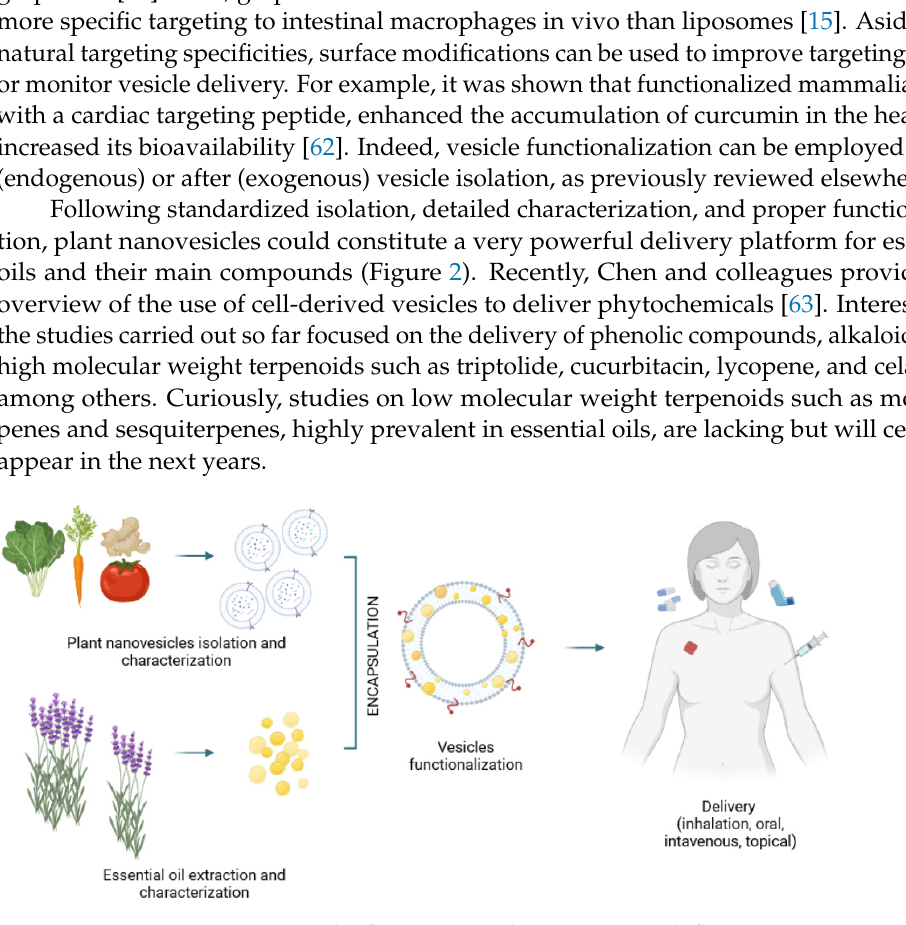
Table 2. Route of administration, advantages, and applications of essential oils encapsulation in plant nanovesicles. How? Route of Administration